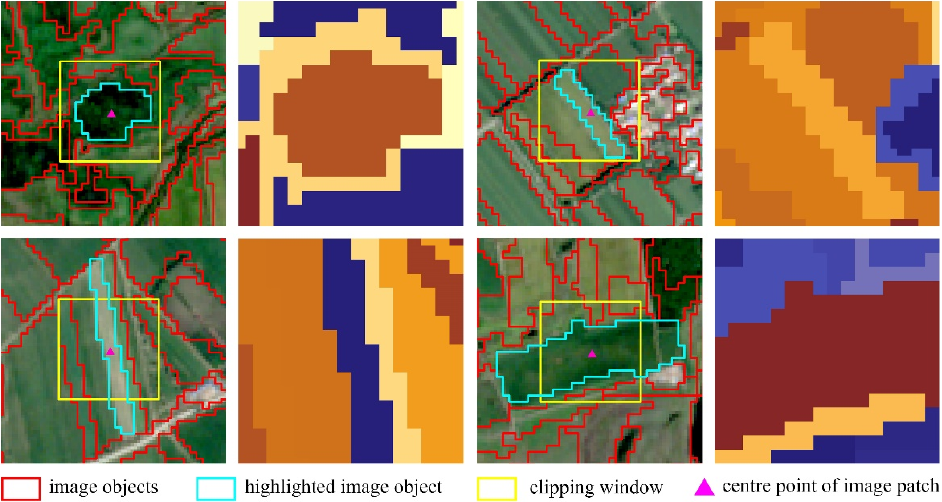
Figure 3. An illustration of image patch generation analysis with the clipping window (yellow rectangle), the center point of image patch (pink triangle), and the highlighted image object (cyan polygons). Other image objects are demonstrated as red polygons. The first row and second row show that the image patch contains a complete and incomplete object,